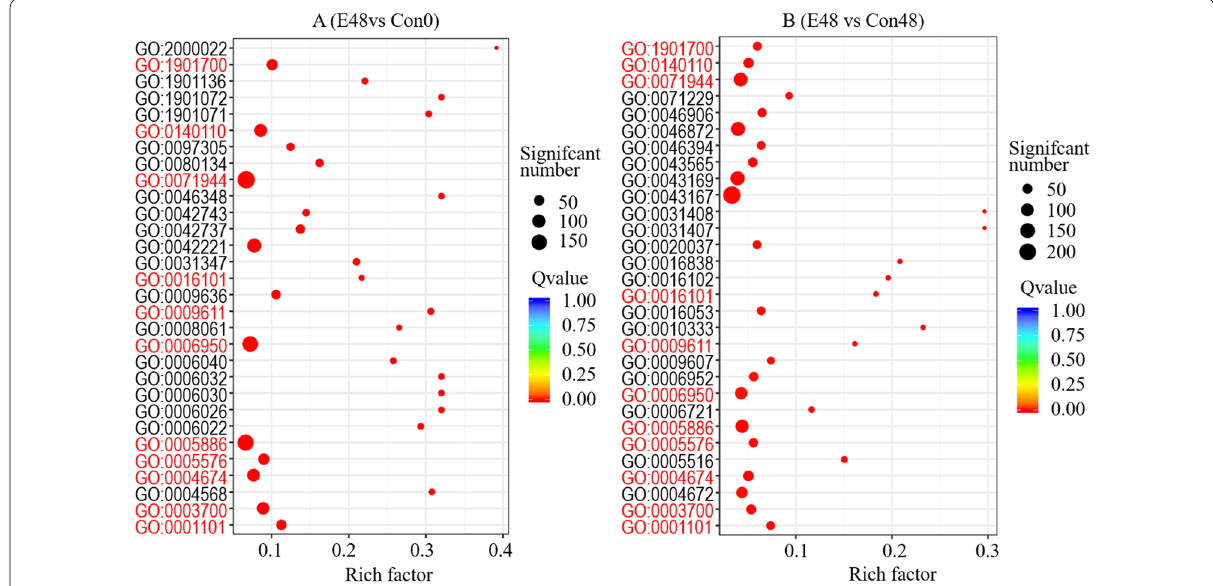
Fig. 6 Scatter diagram of GO classification of protein elicitor EsxA-induced differentially transcribed genes in